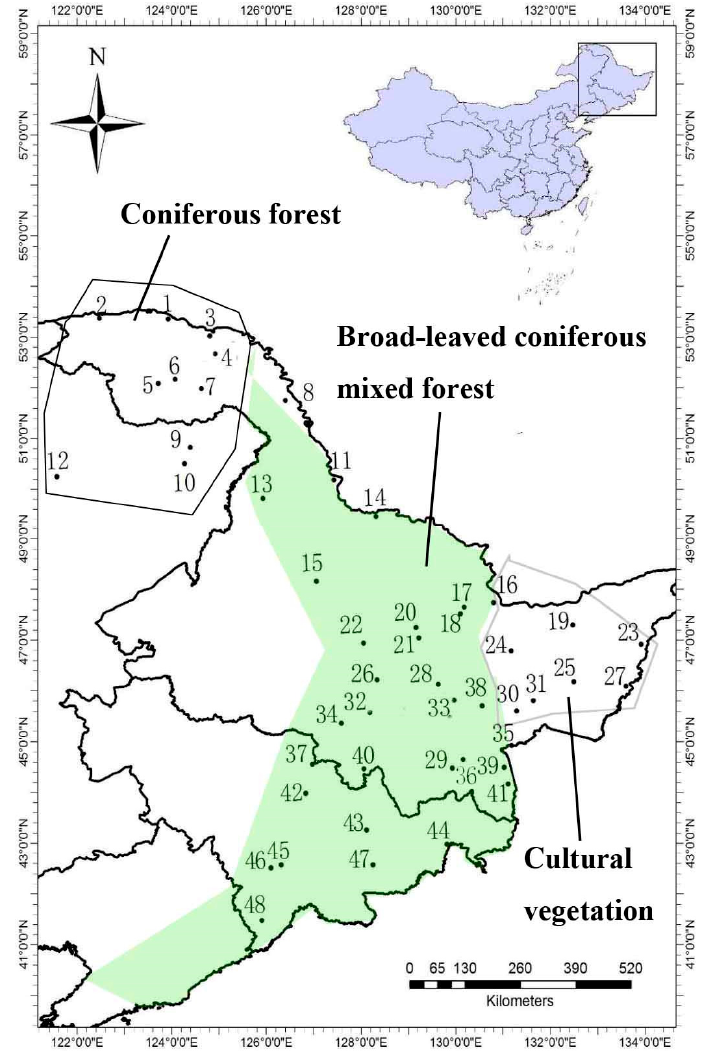
Figure 1. Map of the 48 investigating plots of naturally distributed birch trees in the Xing’an Mountain and the Changbai Mountain in Northeast China and Inner Mongolia Autonomous Region. Plots were numbered in the same order of field data collection.